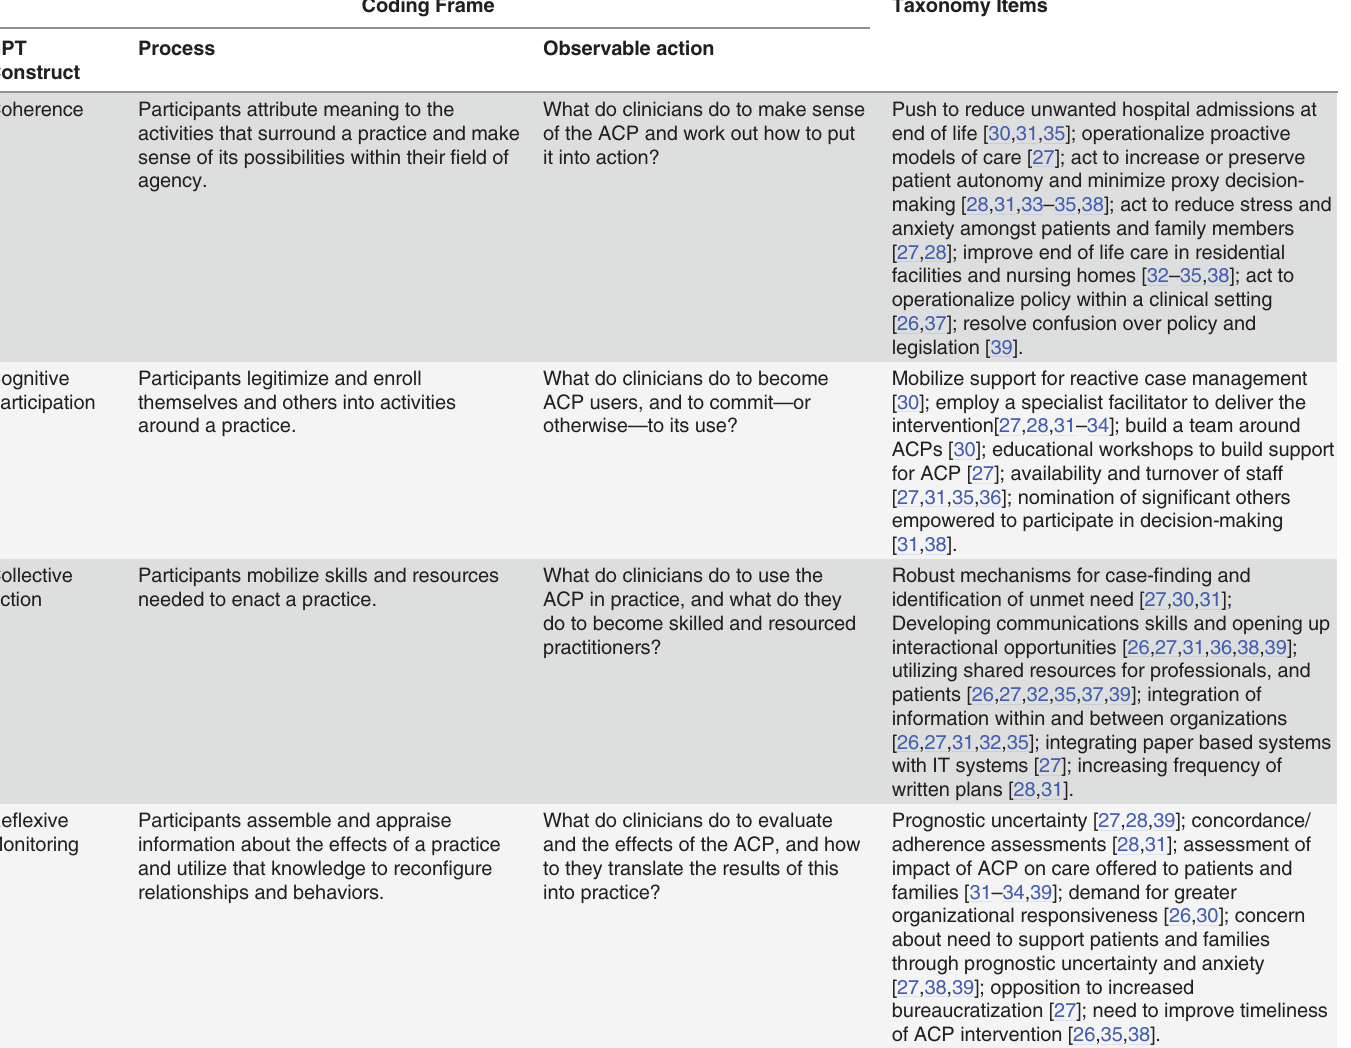
Table 2. Coding frame and Taxonomy